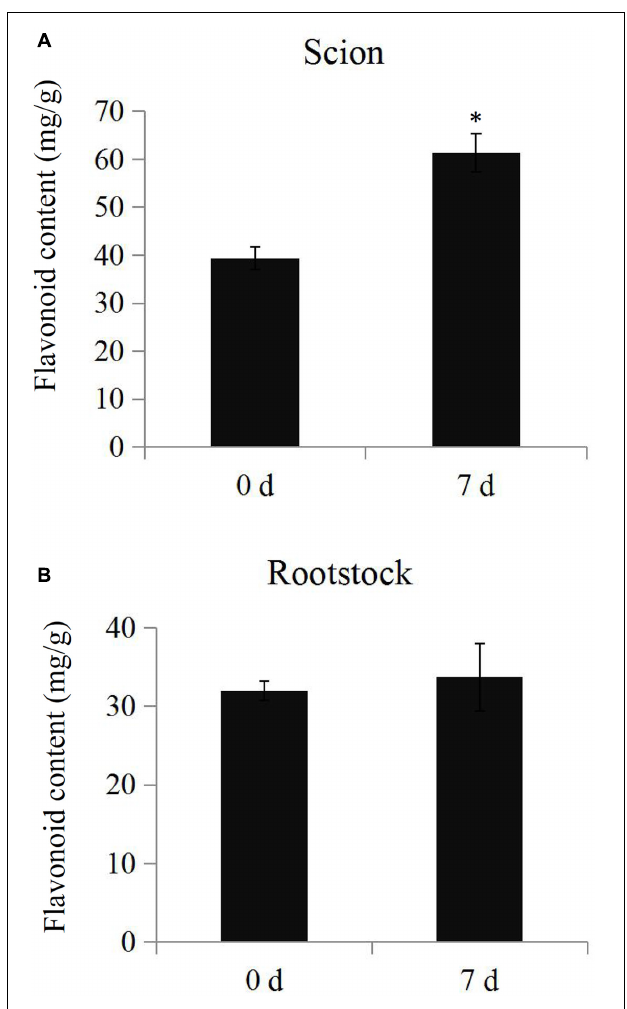
FIGURE 6 | Determination of total flavonoid contents. The total flavonoid contents in the scion (A) and rootstock (B) at time points 0 and 7 days during the grafting process. Significant differences in the total flavonoid contents were indicated by “ ∗